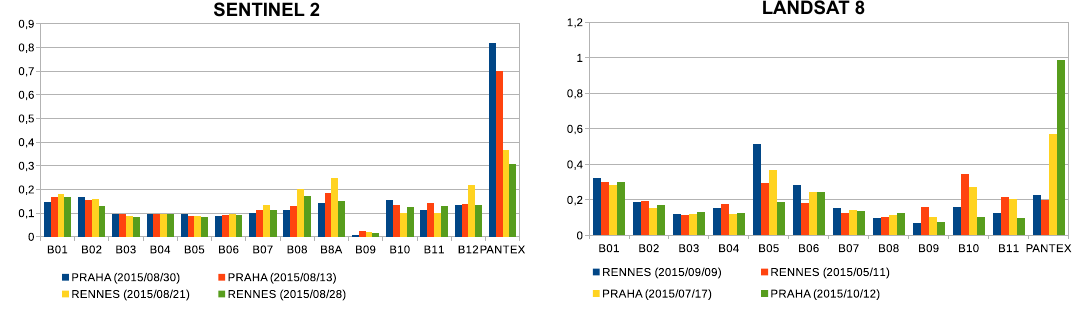
Figure 7. Contribution of the various features in the classification models for the Sentinel-2 and Landsat-8 images. As one can observe, PANTEX indexes have a significant contribution compared to spectral